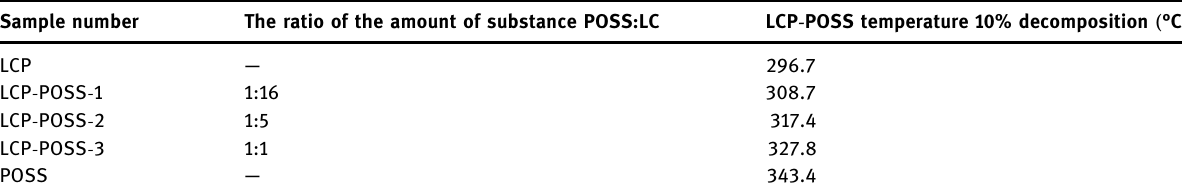
Table 3: Corresponding temperature of the LCP - POSS 10% decomposition Sample number